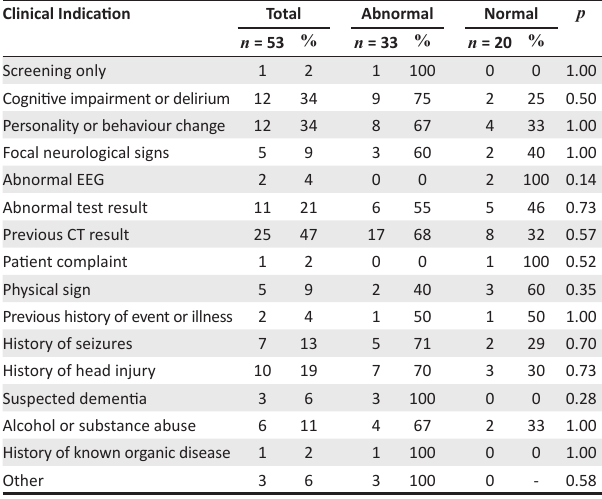
TABLE 2: Clinical indication for patients with normal and abnormal scans. Clinical Indication